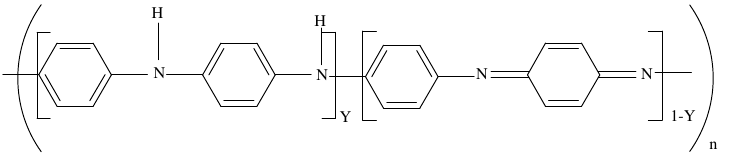
Figure 1 . The general structure of PAn conducting polymers.